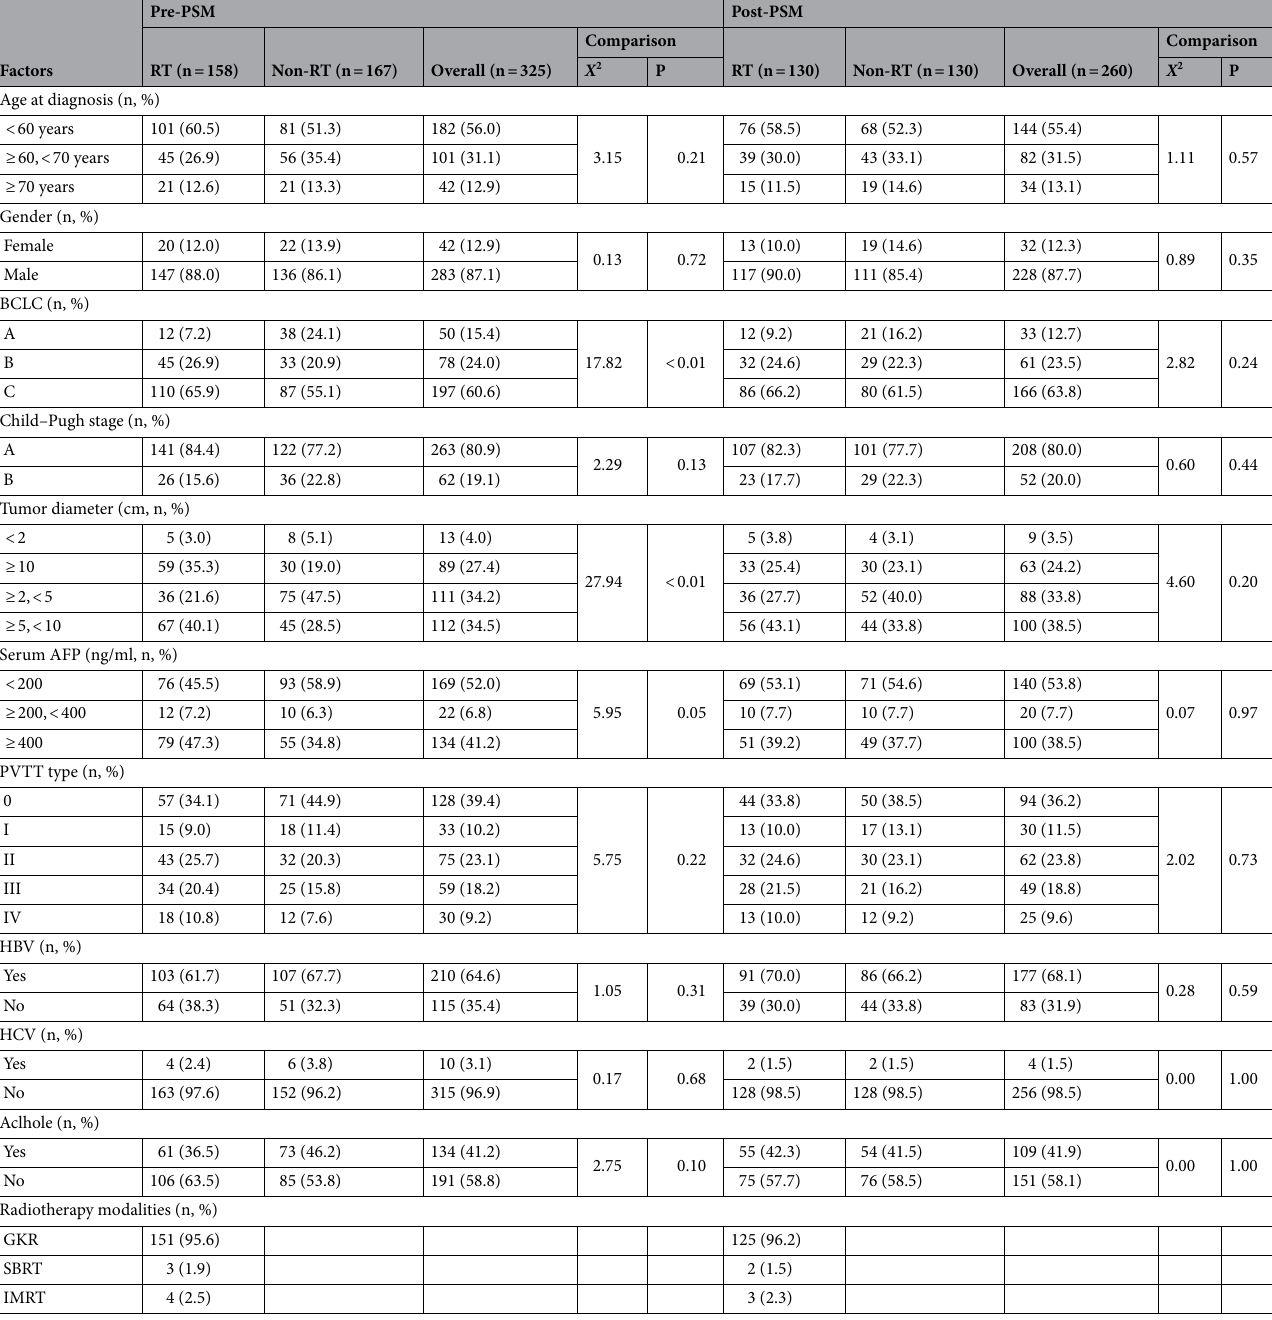
Table 2. Baseline patient characteristics at three tertiary hospitals in China. RT radiotherapy, PSM propensity score matching, AFP alpha fetoprotein, PVTT portal vein tumor thrombus, HBV hepatitis B virus,